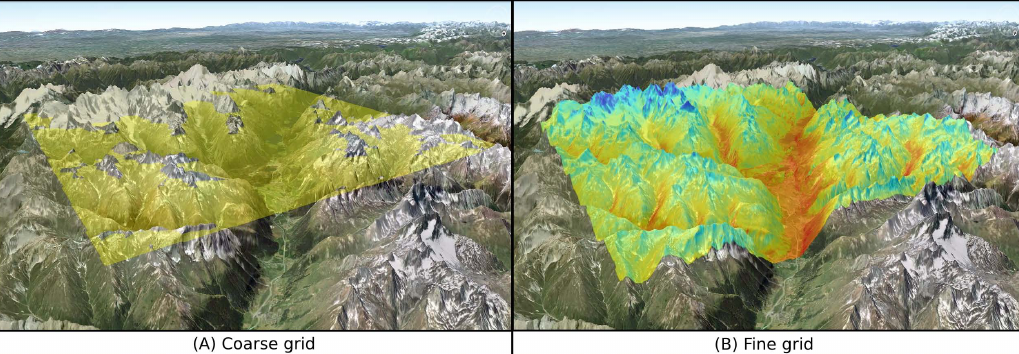
Fig. 1. The scale problem TopoSUB addresses – (A) the complex geometry of mountain topography is aggregated to a mean value in coarse grids which does not necessarily account for sub-grid heterogeneity (B) application of numerical models requires a fine grid in order to account for the effect of this heterogeneity, which is computationally expensive. TopoSUB allows for application of numerical models over large areas through a lumped approach that samples the most important aspects of this